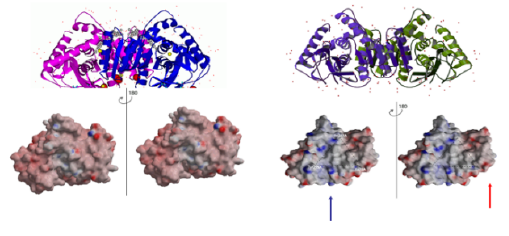
Fig. 1. Ribbon and surface structural representations of malate dehydrogenase from Haloarcula marismortui (on the Left) and Archeoglobus fulgidus (on the